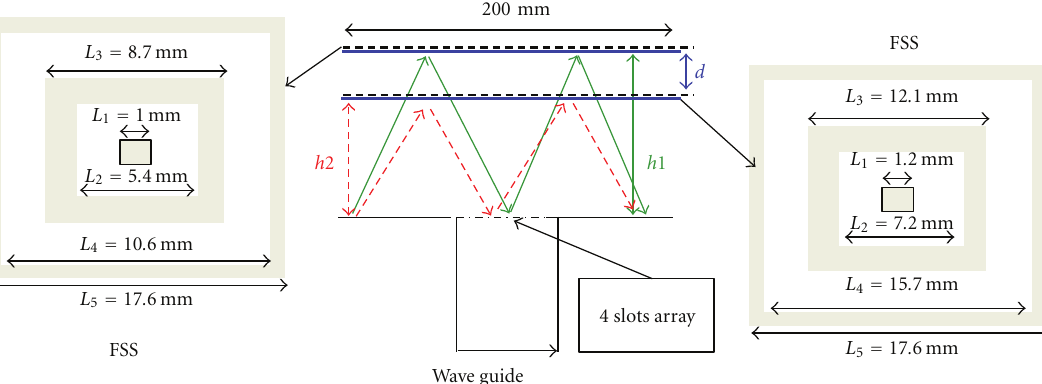
Figure 2: EBG dual-band antenna fed by a rectangular waveguide.